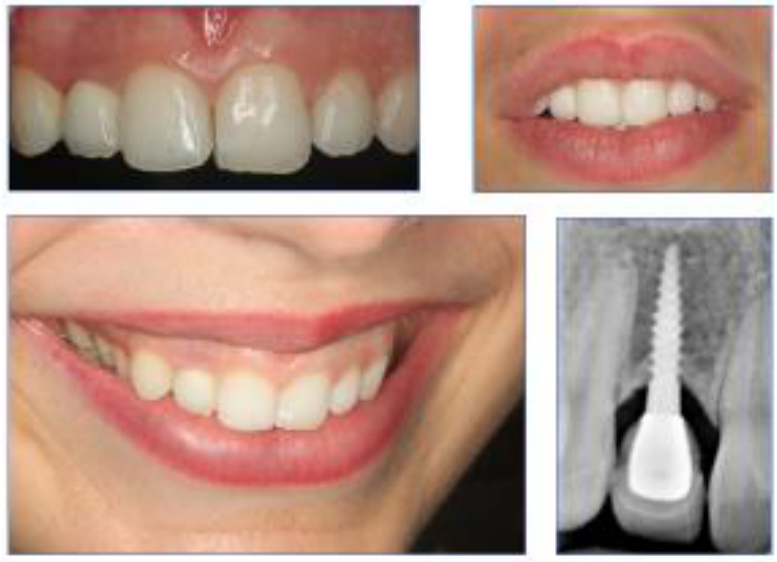
Figure 5. Anterior incisal onlay restoration post cementation, demonstrating improved esthetics.